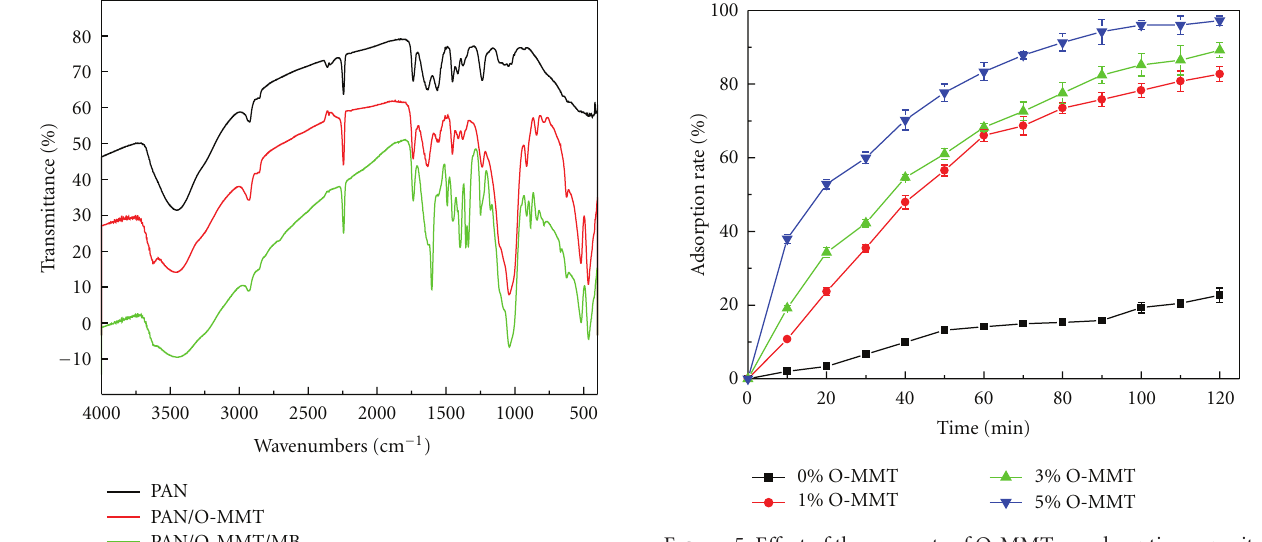
Figure 5: E ff ect of the amounts of O-MMT on adsorption capacity of the membranes for MB.